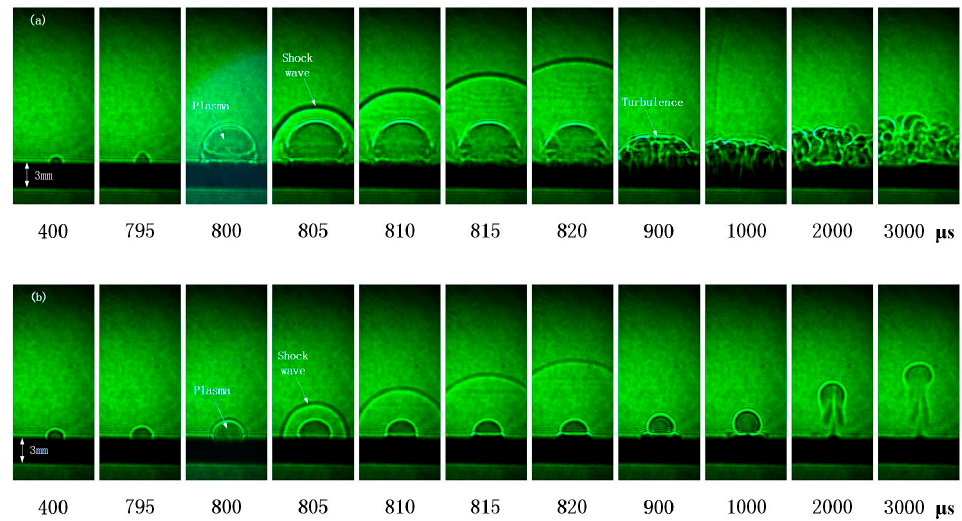
Figure 5. The evolution characteristics of the plasma plume under different spot size combination modes ( a ) the ns spot is larger ( b ) the ms spot is larger.